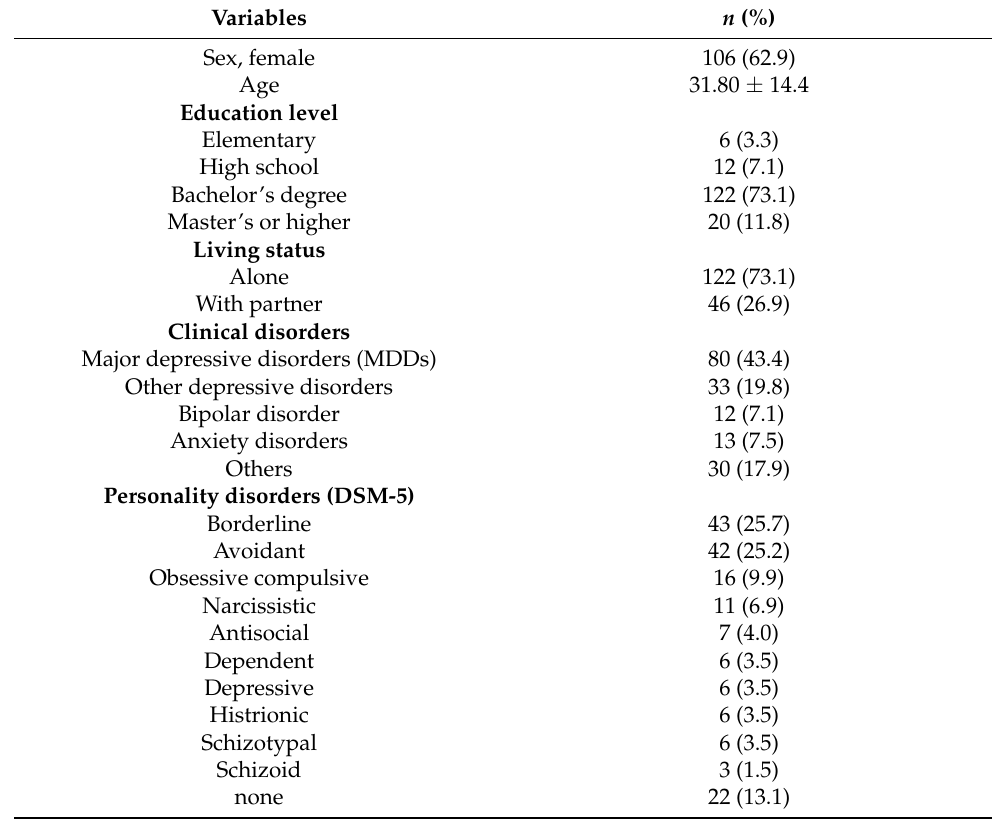
Table 1. Demographic data and diagnoses based on DSM-5 ( n = 168).